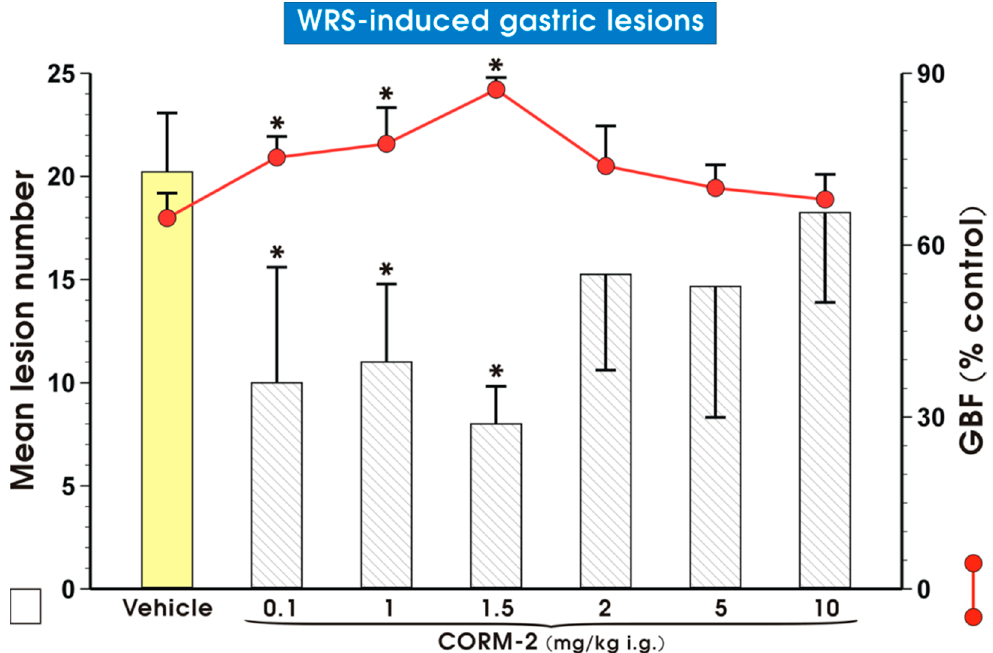
Figure 1. Mean lesion number and gastric blood flow (GBF) in gastric mucosa pretreated with vehicle (saline; oral gavage (i.g.)) or carbon monoxide releasing molecule 2 (CORM-2, 0.1–10 mg/kg i.g.) and compromised 30 min later by water immersion and restraint stress (WRS). Results are mean ± S.D. of 6–8 animals for each experimental group. Asterisk indicates a significant change ( p < 0.05) as compared with vehicle.